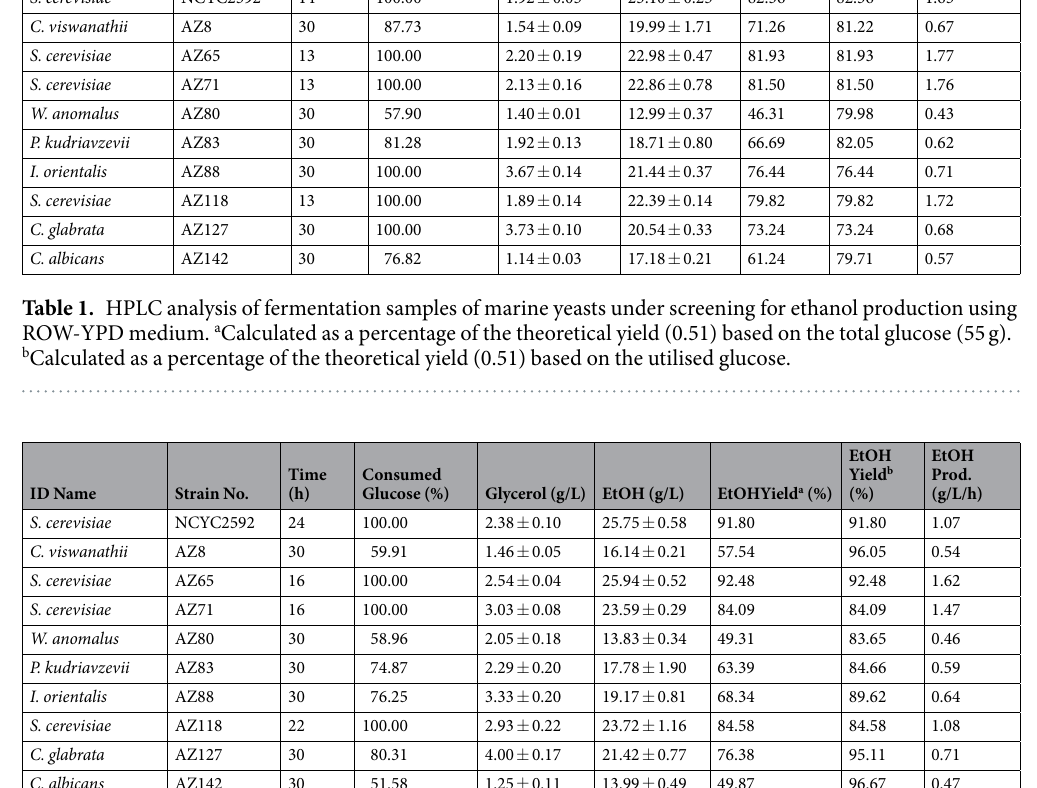
Fig. SF2A. Data revealed that SFR of the reference strain ( S. cerevisiae NCYC2592) dropped from 0.38 h − 1 at 0% NaCl to 0.044 h − 1 at 6% NaCl. The critical inhibitory NaCl concentration for S. cerevisiae NCYC2592 was esti- mated to be 6.40%. In contrast, the critical inhibitory NaCl concentration for S. cerevisiae AZ65 and AZ118 were 13.70% and 14.40%, respectively (Supplementary Fig. SF2A). Plotting the SFR of marine yeasts S. cerevisiae AZ65 and AZ118 in fermentations using SSW and 2X SSW into SF2B showed the data fit the trend lines very well. It was observed that S. cerevisiae NCYC2592 fermented faster in SSW and 2X SSW than those of in NaCl alone. This suggests that certain salt(s) in the SSW improved S. cerevisiae NCYC’s resistance to osmotic stress. This was also confirmed in the fermentations using natural SW. The SFR for all tested yeasts were clearly higher in fermenta- tions using actual SW than that in fermentations with NaCl or SSW (Supplementary Fig. SF2B), suggesting that certain element(s) in seawater provide beneficial impacts for osmotic stress resistance. Fermentation performance of marine S. cerevisiae under high glucose concentrations. Results